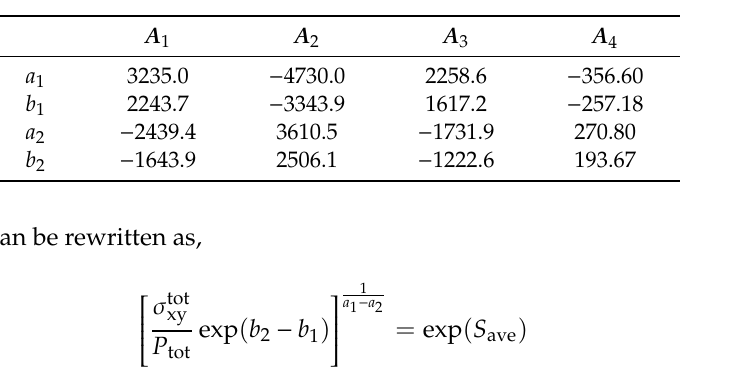
Table 3. Coe ffi cients in Equation